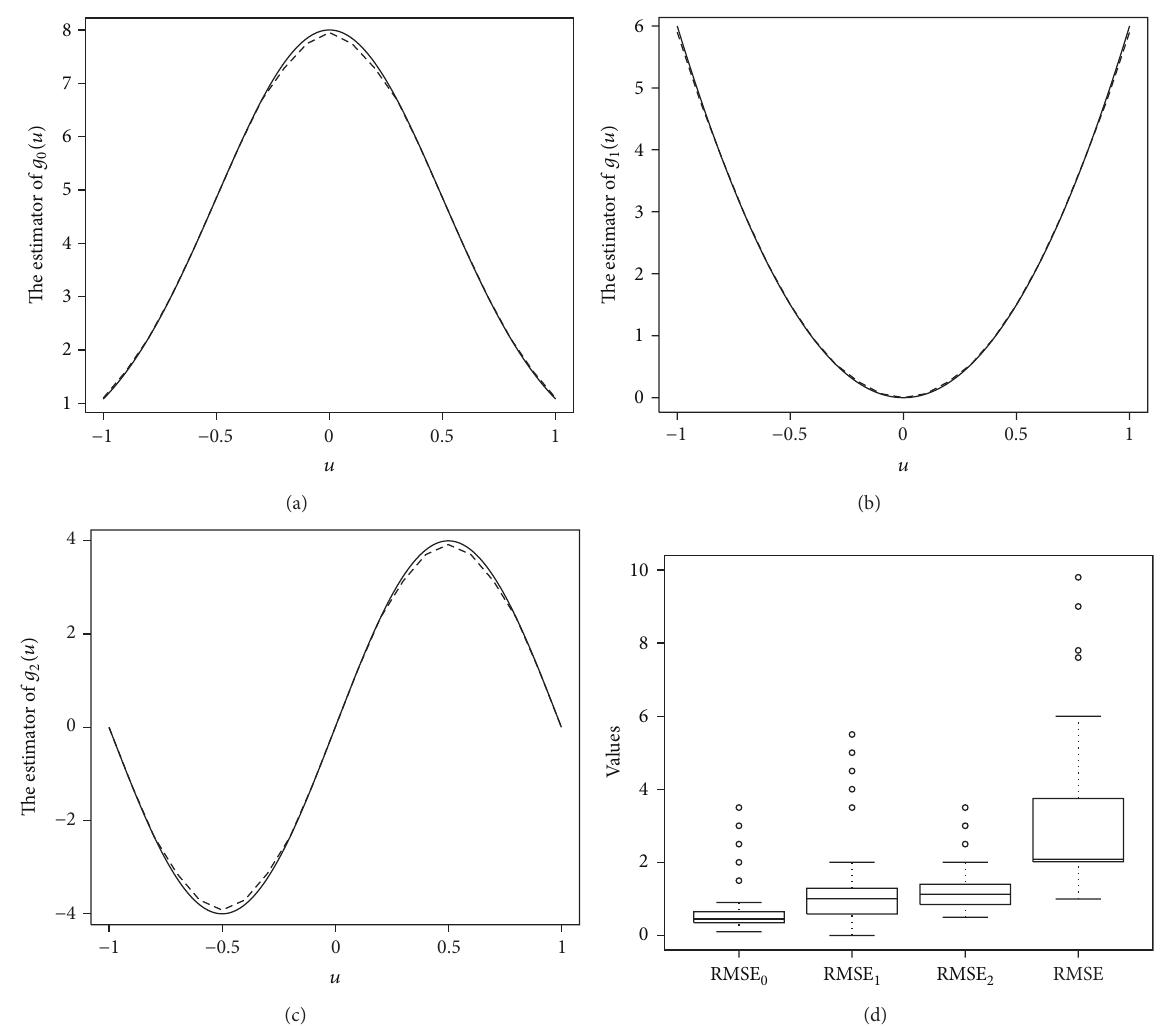
Figure 4: The true curve (solid curve) and the estimated curve (dashed curve); (d) the boxplots of the 1000 RMSE values in estimations of (⋅),𝑔 (⋅) , and 𝑔 (⋅) and the sum of the three 𝑔 0 1 2